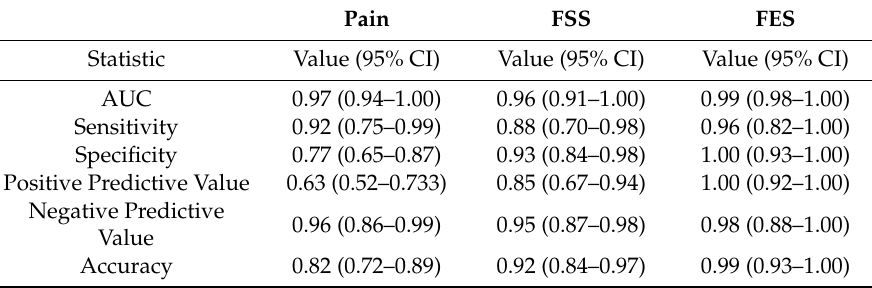
Table 5. Adjusted logistic model